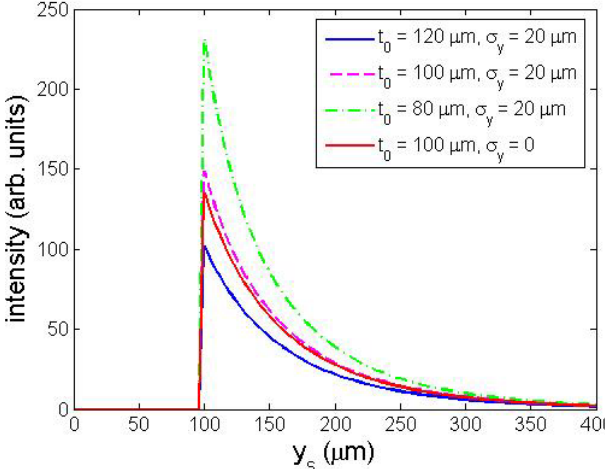
FIG. 14. (Color) 1D projected distribution of the induced cur- rents on the target for a